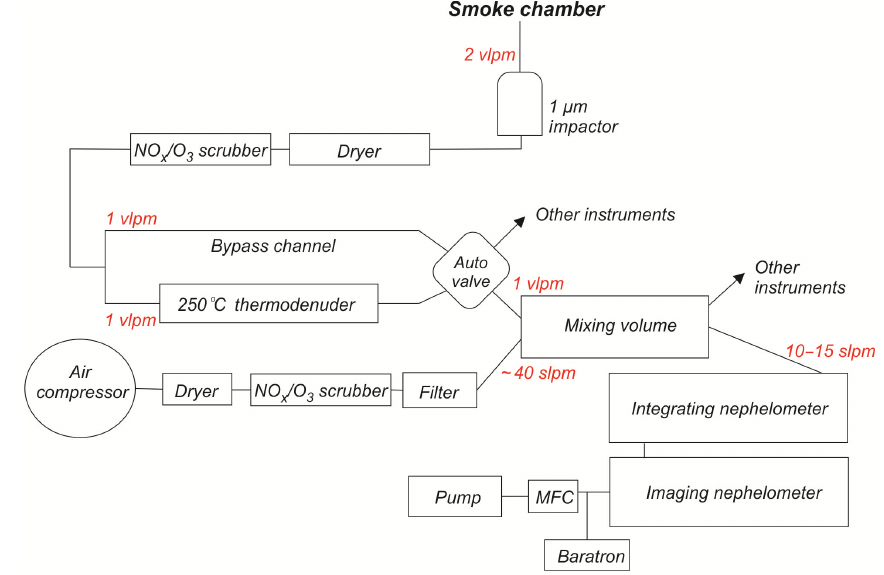
Figure 3. Schematic of NOAA aerosol sampling inlet at Missoula Fire Sciences